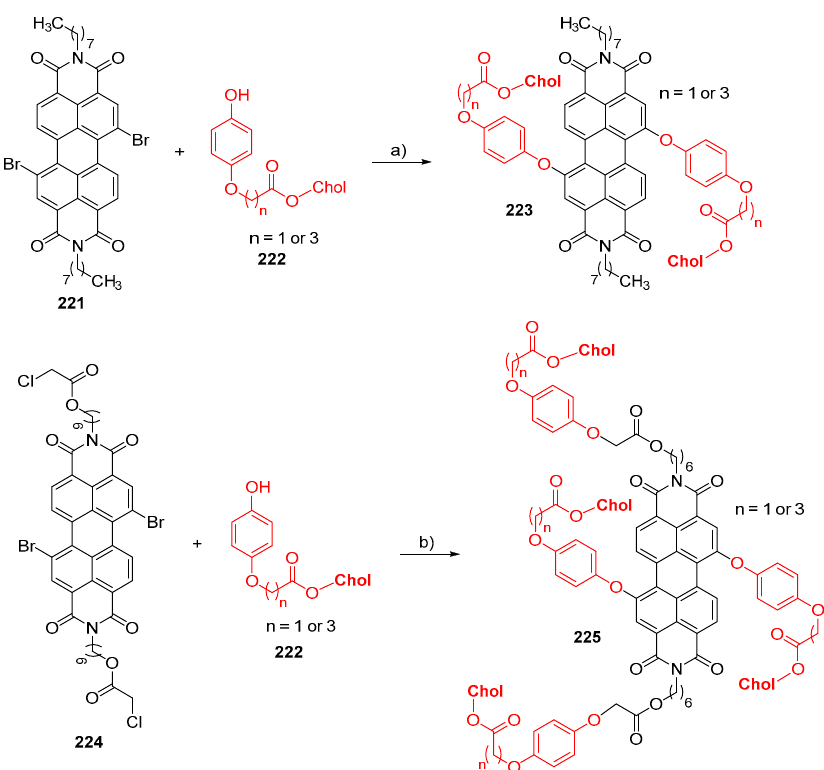
Scheme 55. Synthesis of cholesterol-perylene liquid crystals. Reagents and conditions: a ) K 2 CO 3 ,